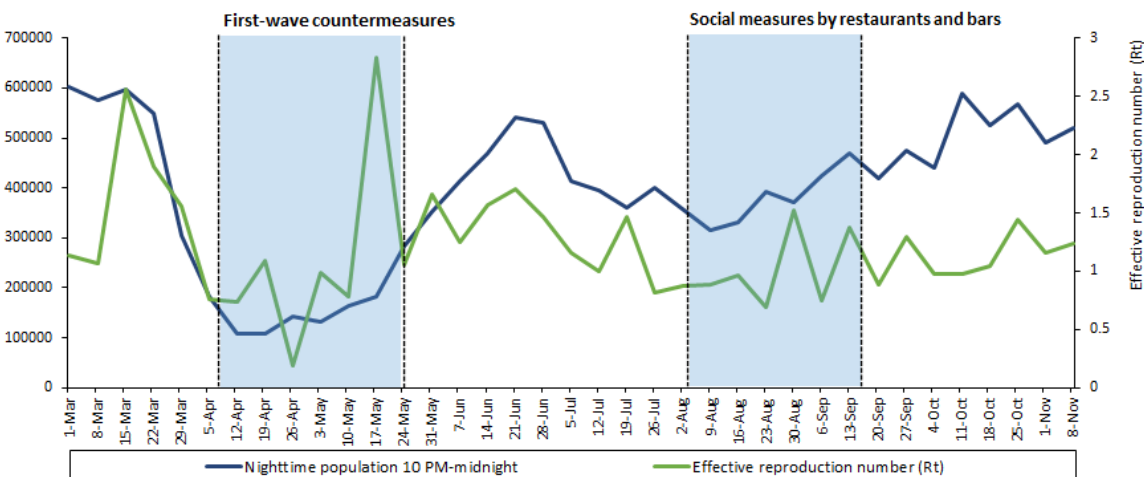
Figure 2. Nighttime population volumes in Tokyo metropolitan areas and the effective reproduction number of COVID-19 per week. The blue line presents the sum of the estimated numbers of people in the seven districts between 10 PM and midnight. The green line presents the effective reproduction number based on the number of confirmed cases in Tokyo. LocationMind xPop © Location Mind